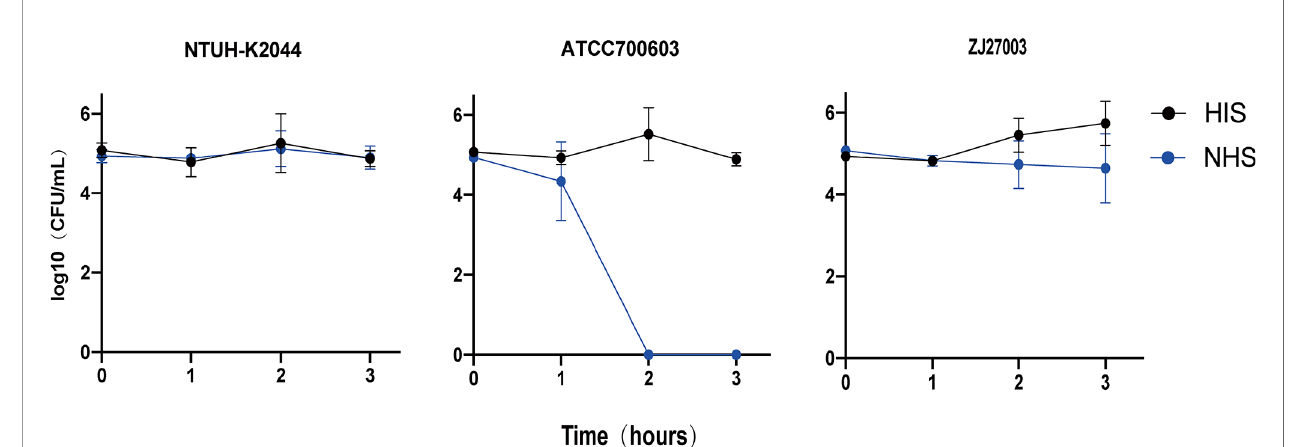
FIGURE 2 | Survival of K. pneumoniae isolates in human serum. K. pneumoniae strains were incubated in 100% NHS or HIS. Samples were enumerated every 60 mins by a plate count. NTUH-K2044 was utilized as a hypervirulent strain control, while ATCC700603 was that of common strain. Triplicate independent experiments were performed for each